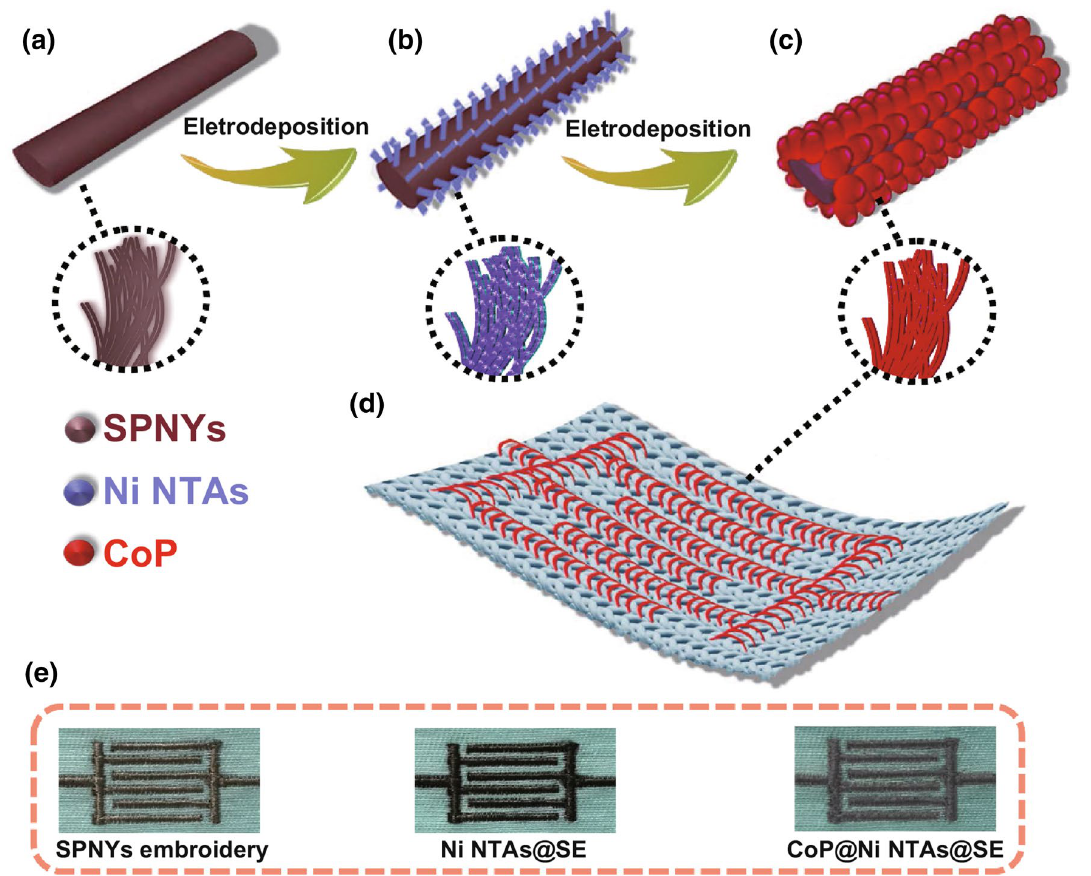
Fig. 3 a – c Schematic diagram of the fabrication CoP@Ni NTAs@SE. d Overview of the CoP@Ni NTAs@SE. e Real images of the SE, Ni NTAs@SE and CoP@Ni